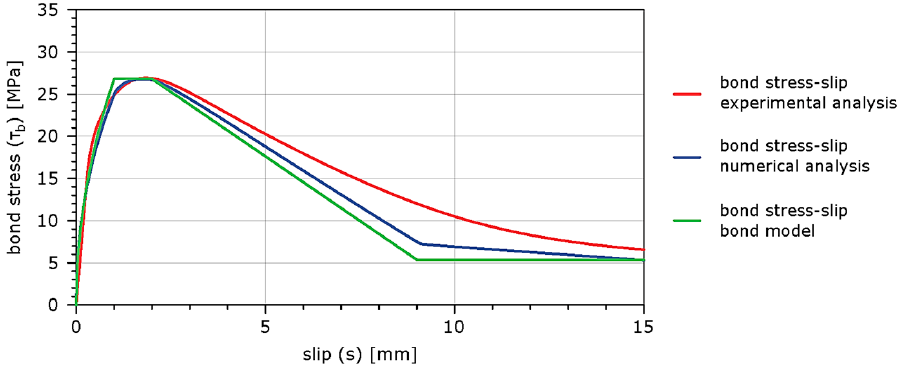
Figure 16. Comparison of bond stress–slip curves for the POT-10 series.